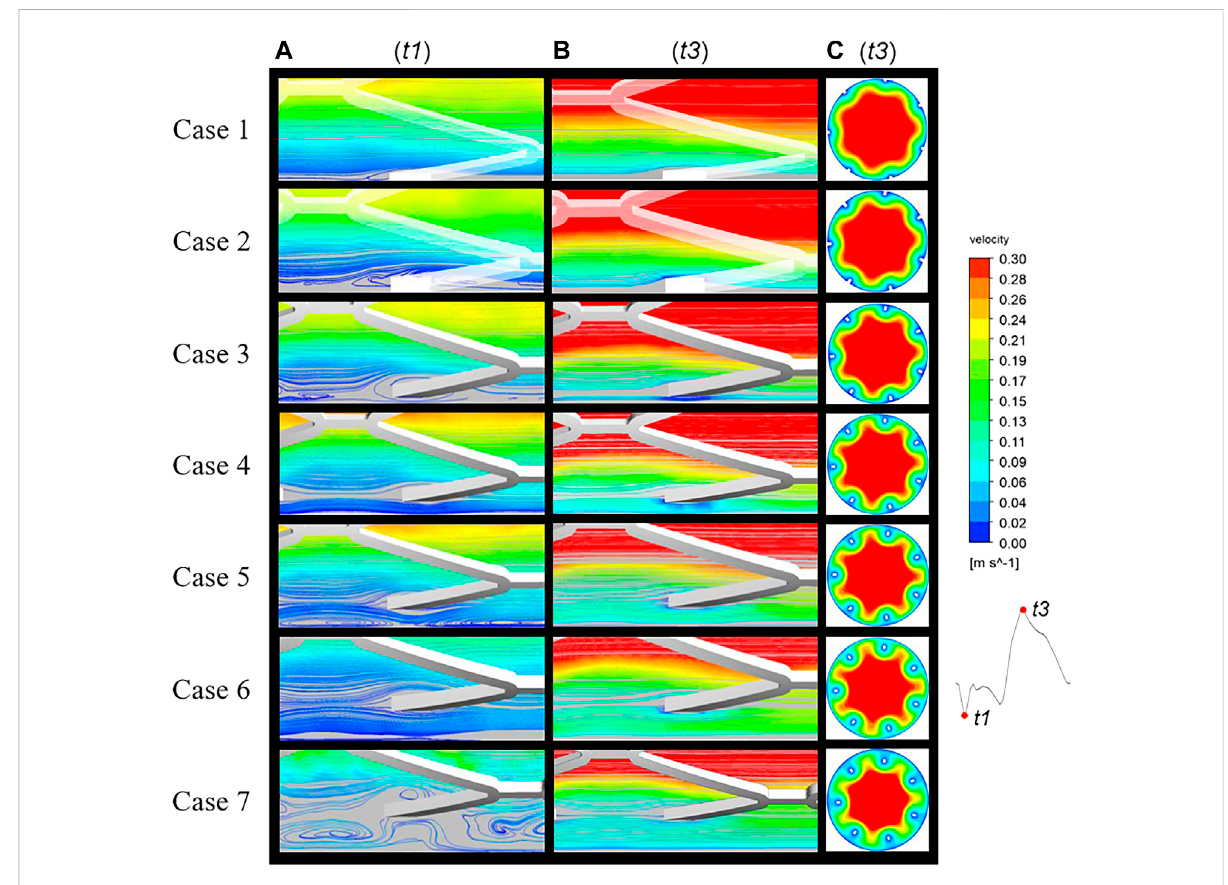
FIGURE 3 Blood fl ow streamlines at two time points of the cardiac cycle: t1, nadir diastole; t3, peak systole. The fl ow near the stents was evidently more disturbed at (A) (t1) than (B) (t3). (C) Mid-stent cross-sections of all cases with the regions of low velocity near the struts having migrated from the vessel wall to the